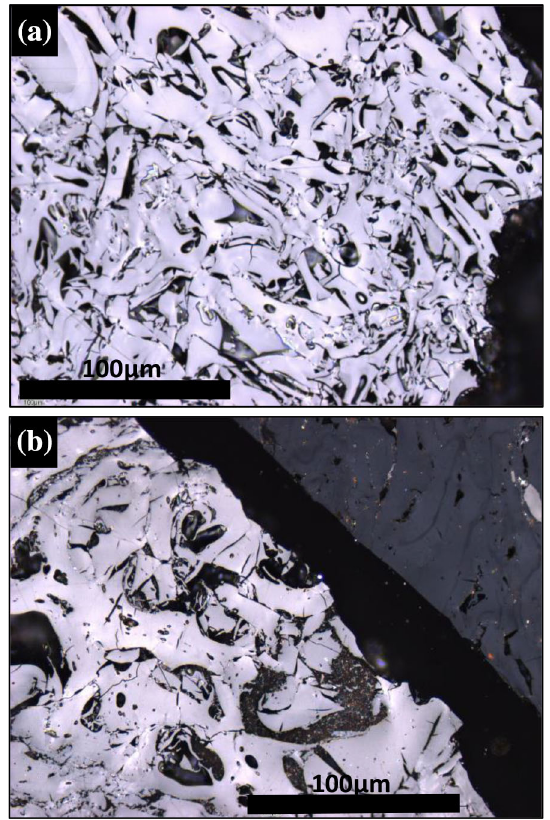
Fig. 9 a , b Fusinites observed in the inertinite-rich sample. 9 500 magnification, reflected light with oil immersion. Scale is indicated